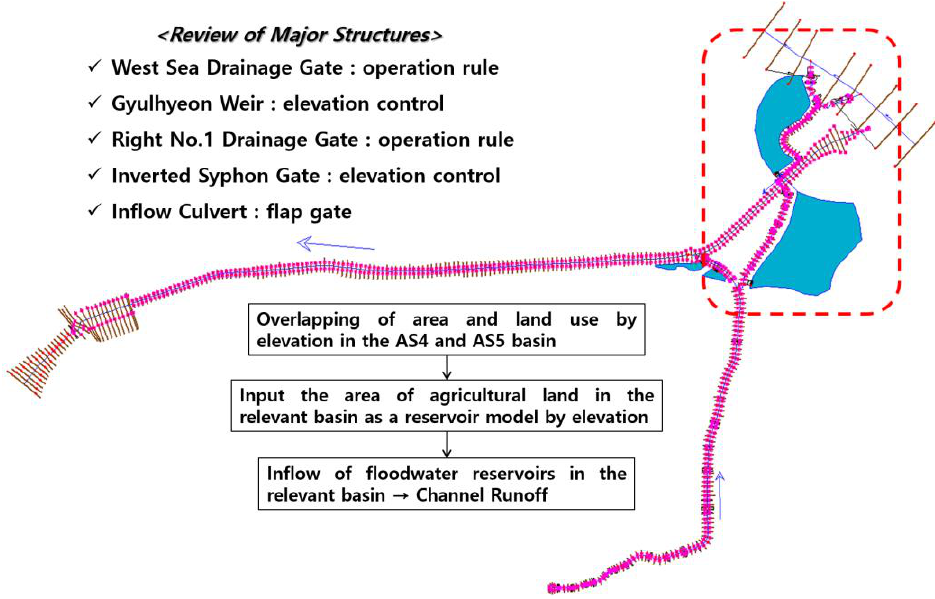
Figure 7. Final Model Selection.